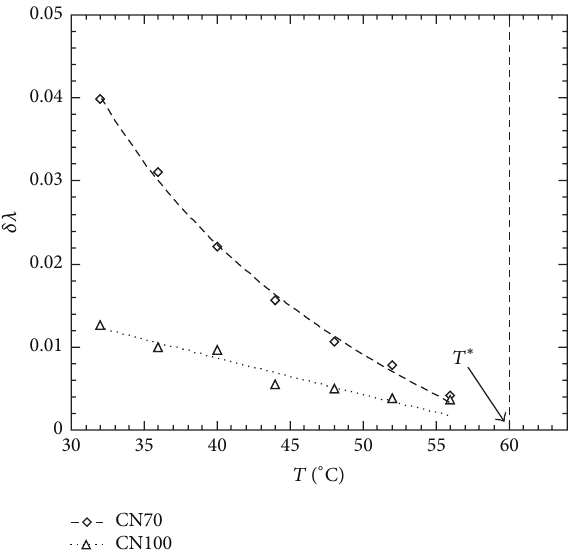
Figure 10: Plot of 𝑑 versus 𝜆 . The data points are connected by lines. Compared to CN70 and CN50, changes in layer spacings are smooth in CN100. The largest 𝜆 and the smallest variation in layer spacing are observed for CN70 which has the highest 𝑇 𝑔 . Arrows point to 𝜆 values at 𝑇 ∗ = 60 ∘ C.